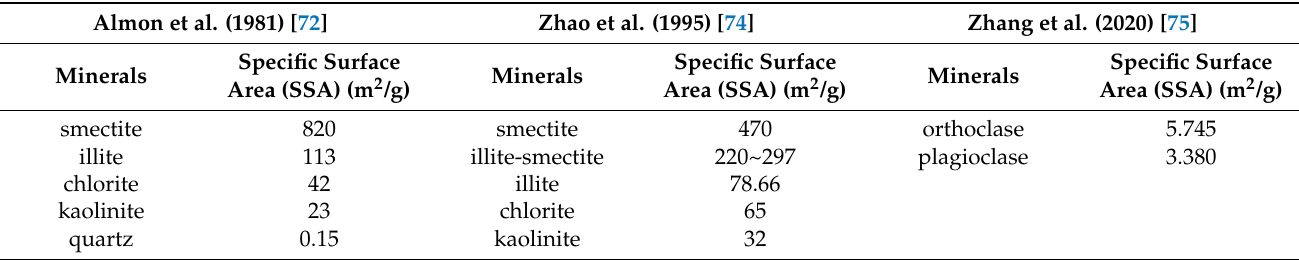
Table 4. Specific surface area (SSA) of common minerals in petroliferous